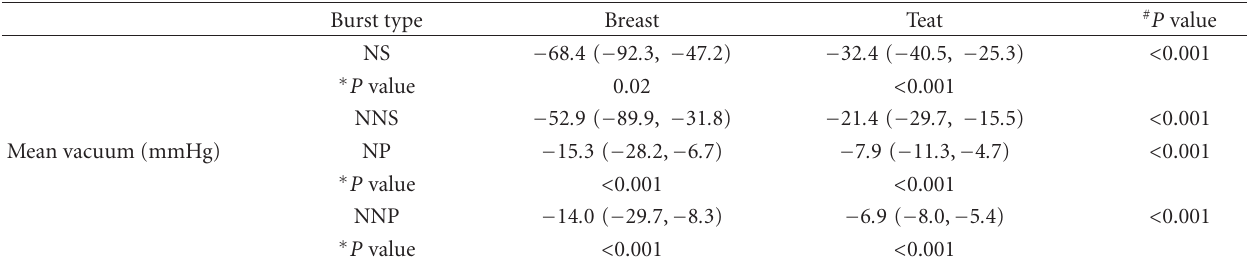
Table 6: Vacuum relationships during the monitored breastfeed and the feed from the experimental